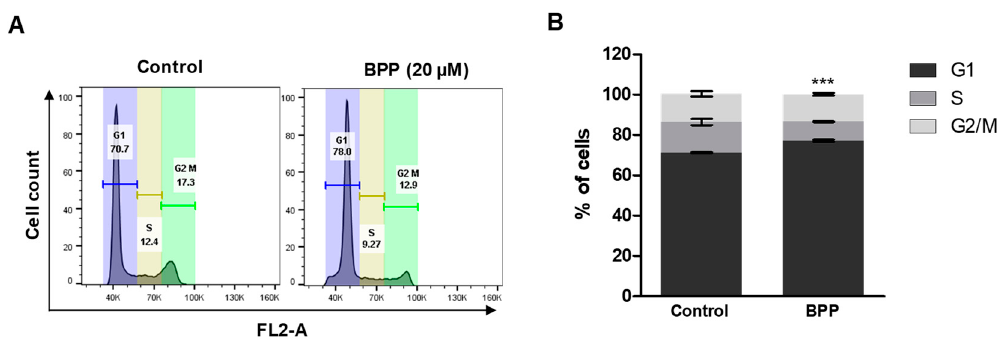
Figure 6. BPP-induced changes in cell cycle progression in Jurkat cells. ( A ) Cell cycle analysis of compound-treated cells. Cells were PI (propidium iodine)-stained for 30 min and analyzed by flow cytometry. ( B ) Percentage G1, S, G2/M phase cells were determined from triplicate experiments.